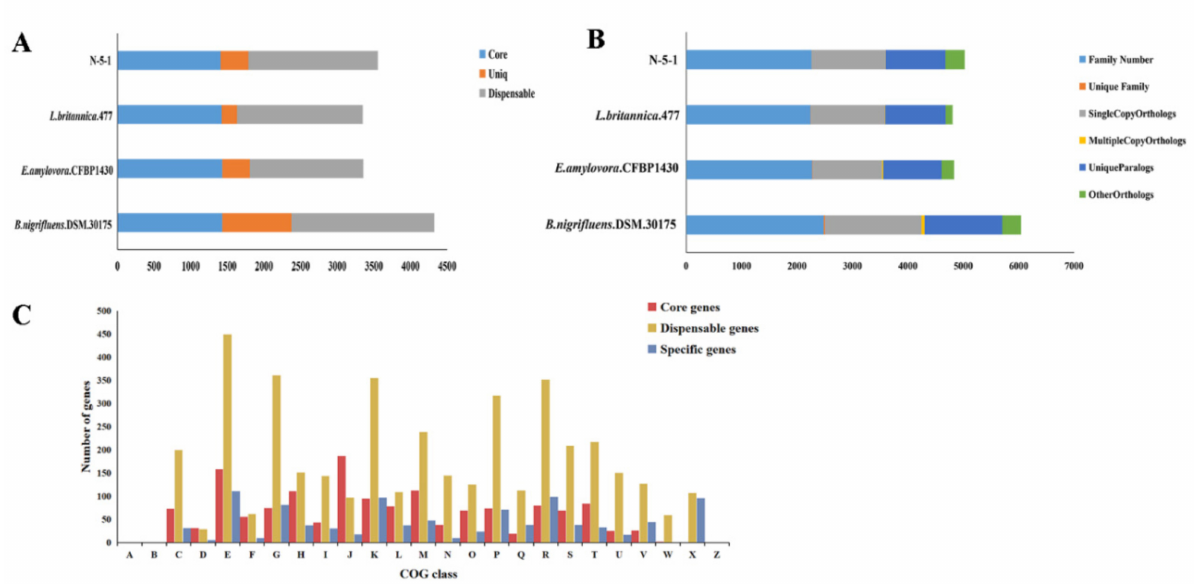
Figure 7. Comparative analysis of L. populi N-5-1 with three closely bacterial genomes. ( A ) Chart showing numerous core genes, dispensable genes and specific genes for each of the four stains. These three closely related strains are B. nigrifluens , E. amylovora , L. britannica , and L. populi N-5-1, respectively. The different gene types are shown in different colors and sorted according to the assigned number of different genes. ( B ) Numbers of gene families shared by different strains. Different colors represent different homologous genes. Strains are ranked from top to bottom according to the number of different genes. ( C ) Proportion of genes enriched in the clusters of orthologous groups (COG) categories in the core genes, dispensable genes and specific genes according to COG database